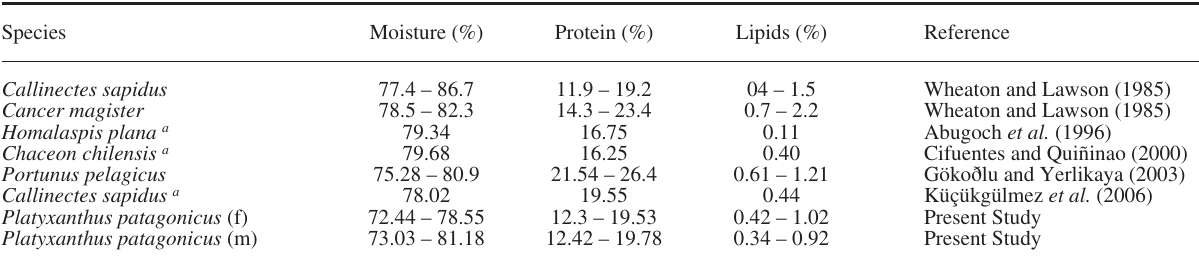
Table 1. – Percentage of moisture, protein and lipids in muscle relative to the wet weight in some brachyuran species as reported by several